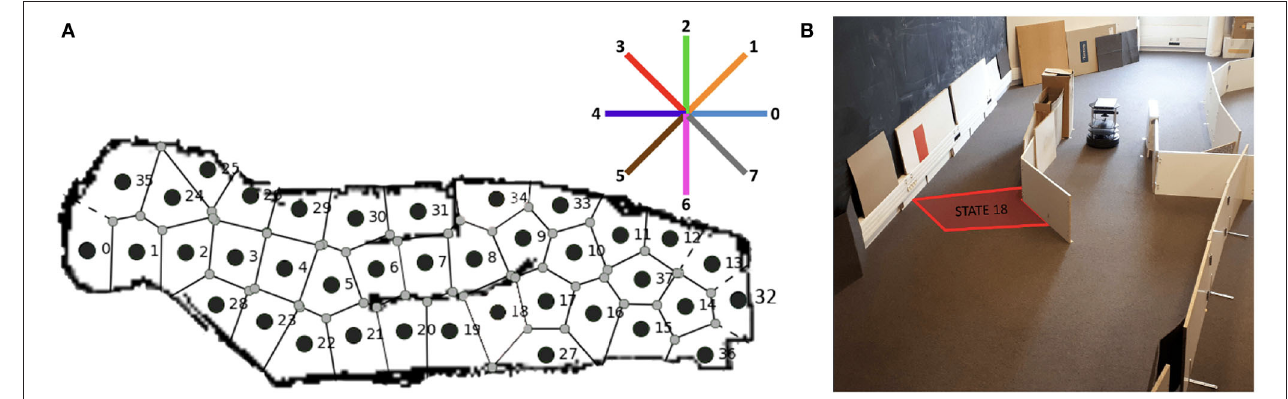
FIGURE 8 | Description of the experimental set-up. (A) Map of the discrete states of the maze. The eight-pointed star indicates the cardinal directions in which the robot can move. These directions are the same used for the experiment in Section 3 (B) Photo of the real Turtlebot approaching the initial rewarding state 18, highlighted in the figure. Adapted from Dromnelle et al.